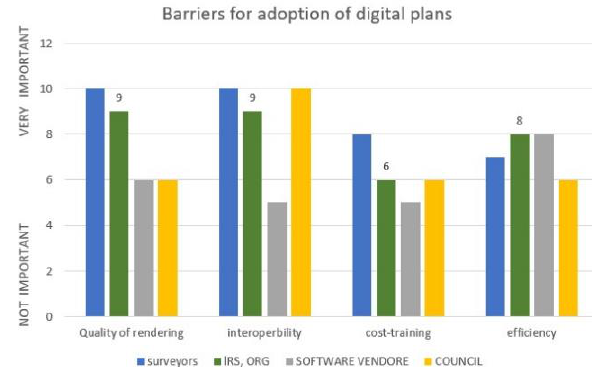
Figure 6 : Barriers for Adoption of Digital Plans